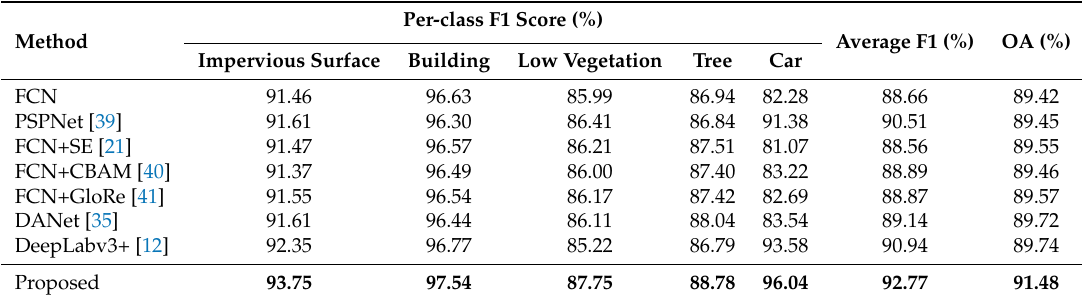
Table 3. Results on the Potsdam dataset in terms of per-class F1 score, average F1 score, and overall accuracy